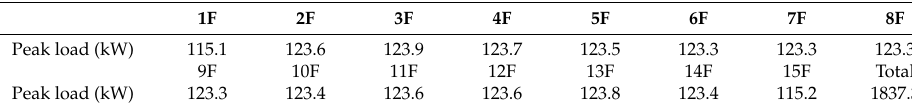
Table 6. Unit Drilling Cost per Meter.